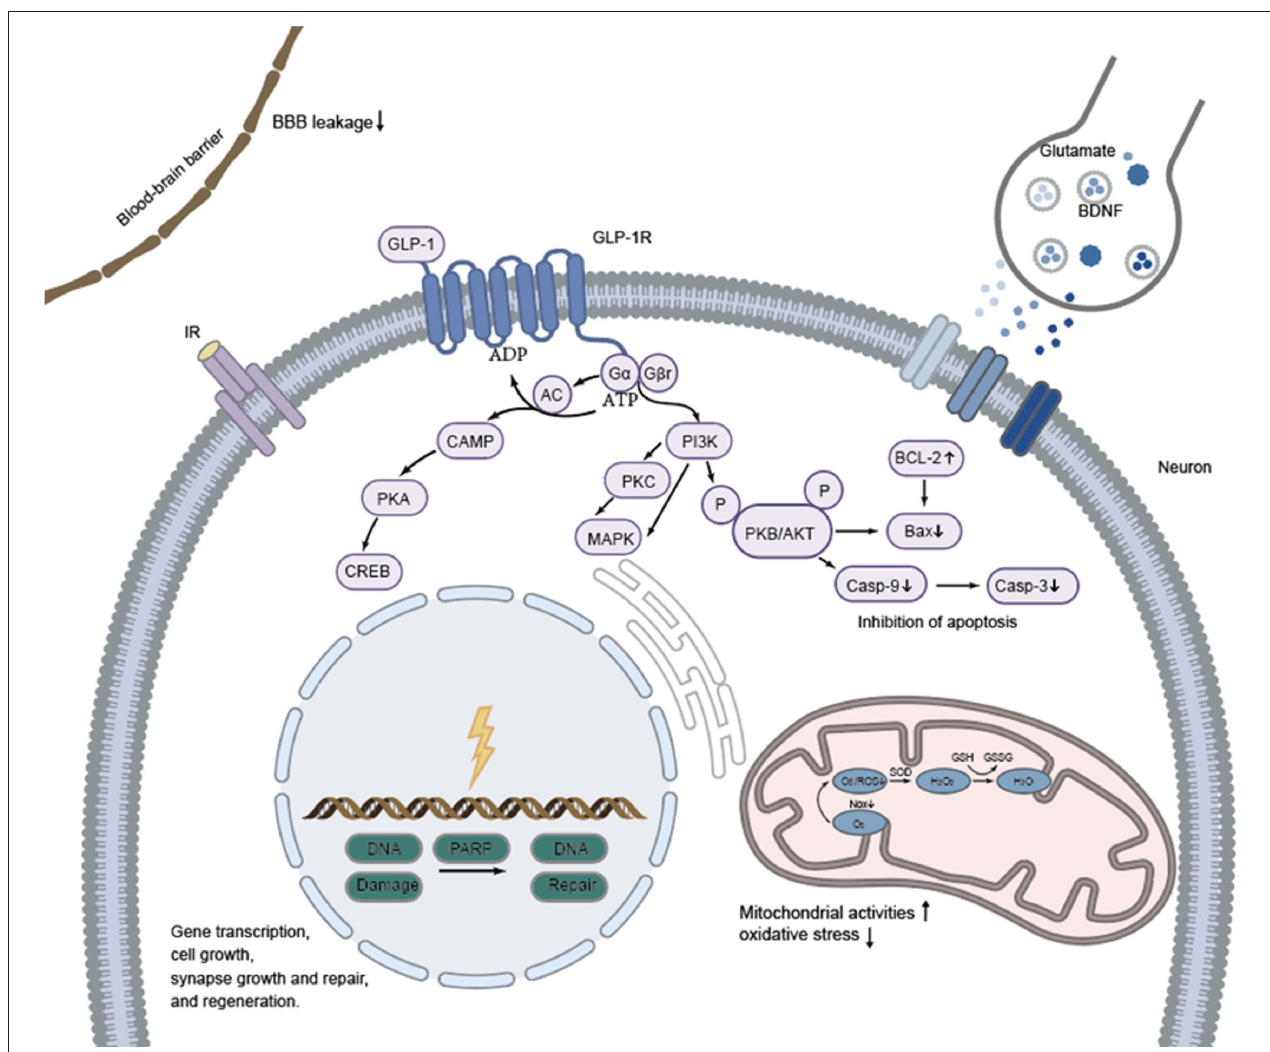
FIGURE 1 | Proposed mechanisms of neuroprotective efficacy exerted by GLP-1 and GLP-1RAs against stroke in animals. Effects of GLP-1 and GLP-1RAs are mediated by binding to a specific, seven-transmembrane GLP-1R which is positively coupled to the adenylyl cyclase (AC) system. GLP-1 and GLP-1RAs acts directly by the cAMP/PKA signal pathway to facilitate gene transcription, synapse growth and repair, cell growth, and regeneration. The G βγ dimer stimulates the PI3K, which then activates PKB/AKT pathway to inhibit apoptosis. In addition, GLP-1 and GLP-1 RAs play a role through reduction of blood-brain barrier leakage and neurotransmitter transmission among synapses as